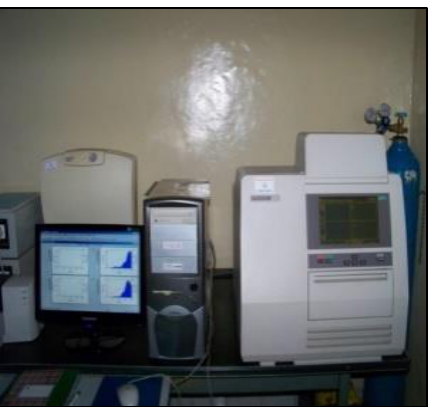
Figure 1. TLD-700H